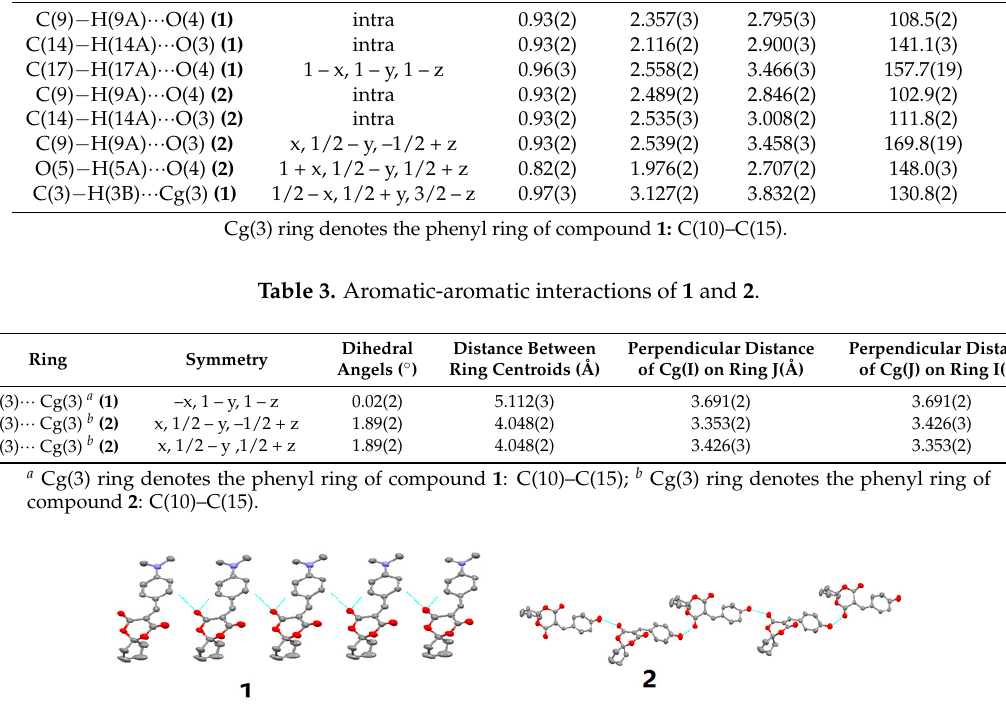
Figure 2. The packing arrangement in a unit cell of 1 and 2. Table 2. Intra- and intermolecular hydrogen bonds and C–H··· π supramolecular interactions in 1 and 2 .